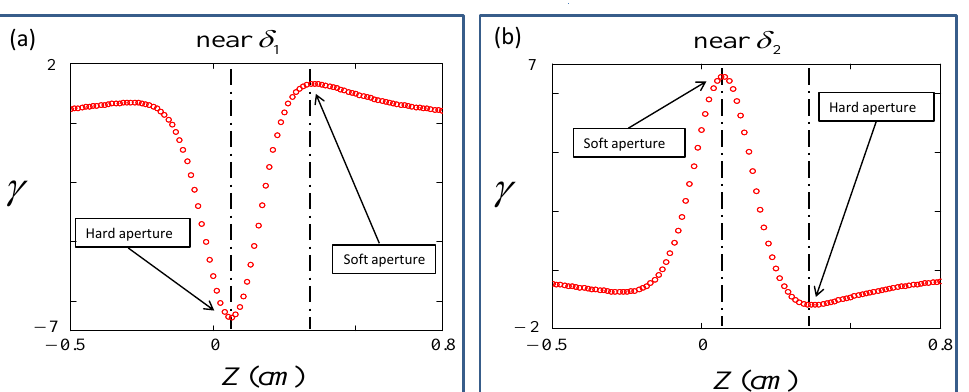
from M 1 . Positive 1 . 2 , from M 2 . Positive values of Z 2